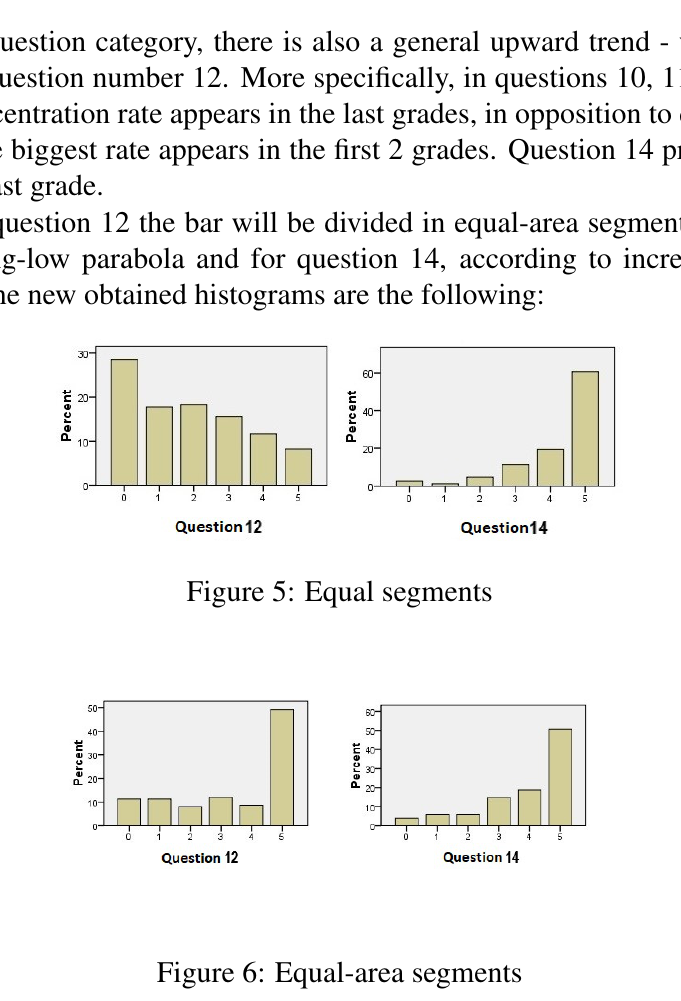
Figure 4: Question Category: Teaching